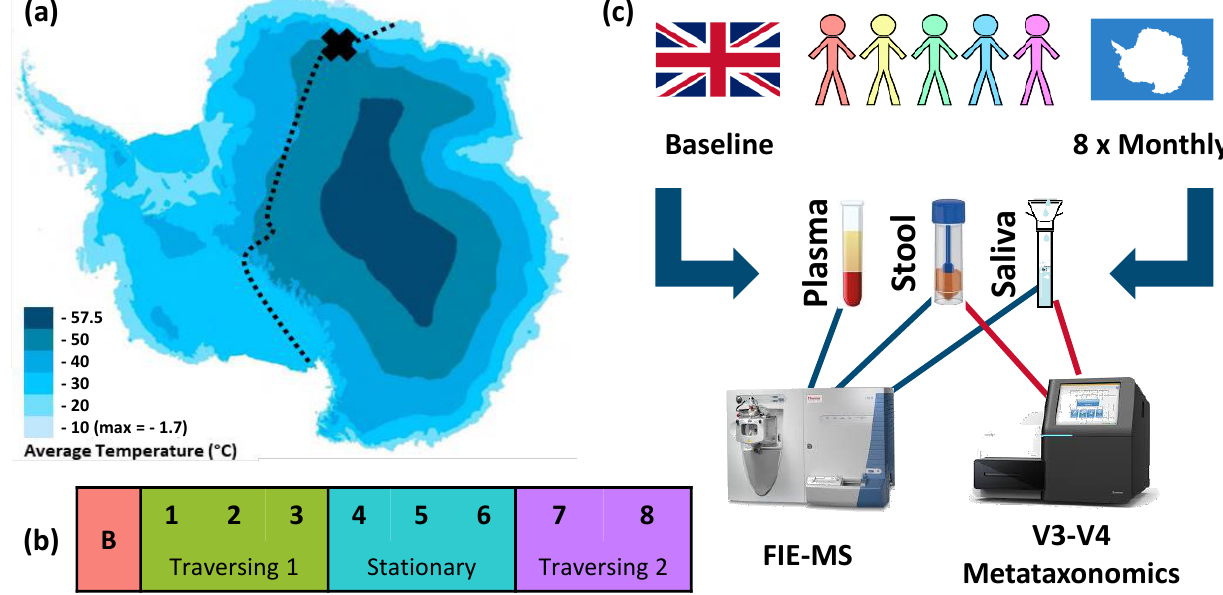
Figure 1. TAWT journey and experimental methodology of multi-omic analysis. ( a ) Planned route for TAWT journey with X showing the location of stationary campus after first period of traversing, adapted to show average temperatures [18]; ( b ) division of collected samples based on activity period used in statistical analysis: B = baseline; outward traversing period of months 1 to 3, stationary period of months 4 to 6, and return traversing period of months 7 and 8; and ( c ) experimental methodology of sampling from five participants with omic analysis of FIE-MS metabolic fingerprinting of plasma, stool, and saliva and metataxonomic fingerprinting of stool and saliva.